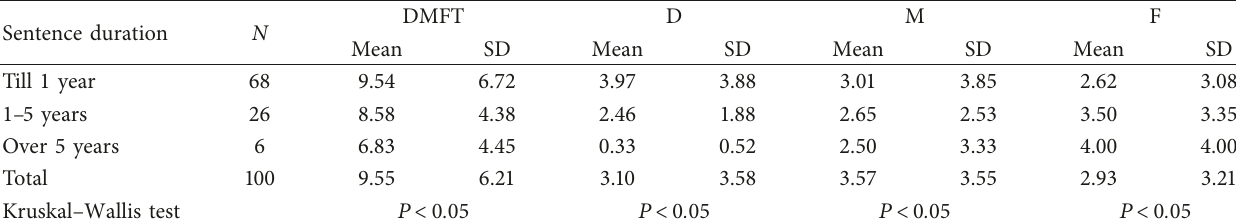
Table 6: DMFT, D, M, and F values according to the sentence